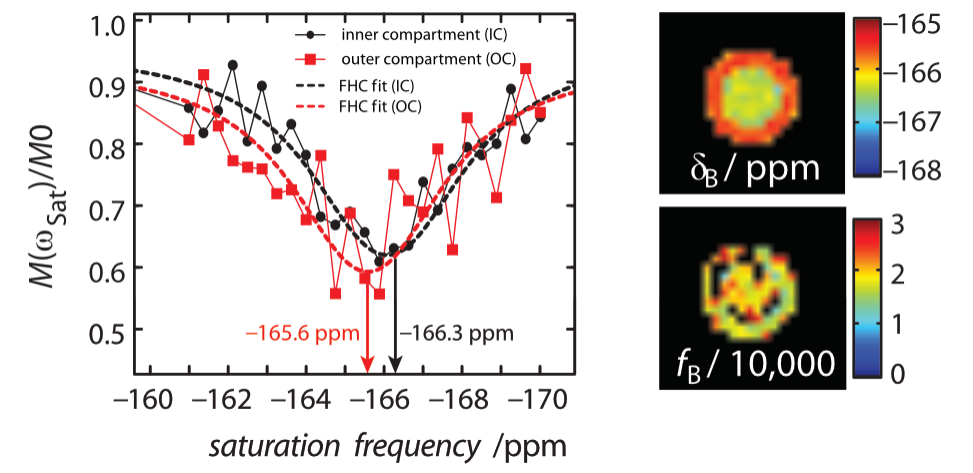
Figure A3. For an experimental setup of equal concentrations of CrA-ma in the inner and outer compartment (IC and OC) of the double bubbling phantom ([CrA-ma IC ] = [CrA-ma OC ] = 10 µ M), we observed a chemical shift difference of the CEST resonance, δ B map, while the Xe in DMSO resonance, δ A , remained constant. The equal concentrations of CrA-ma in the IC and OC was confirmed by the map of the ratio of bound and free Xe, f B , that showed no significant difference (bottom right). The black squares within the phantom correspond to values close to zero. They originate from partial volume effects because of FHC fitting of the glass wall of inner 5 mm NMR tube. The fit result of the δ B map was not compensated by another fit parameter. Taking into account the very sensitive shift of Xe@CrA-ma with temperature, we assigned this difference in chemical shift to a temperature difference between both